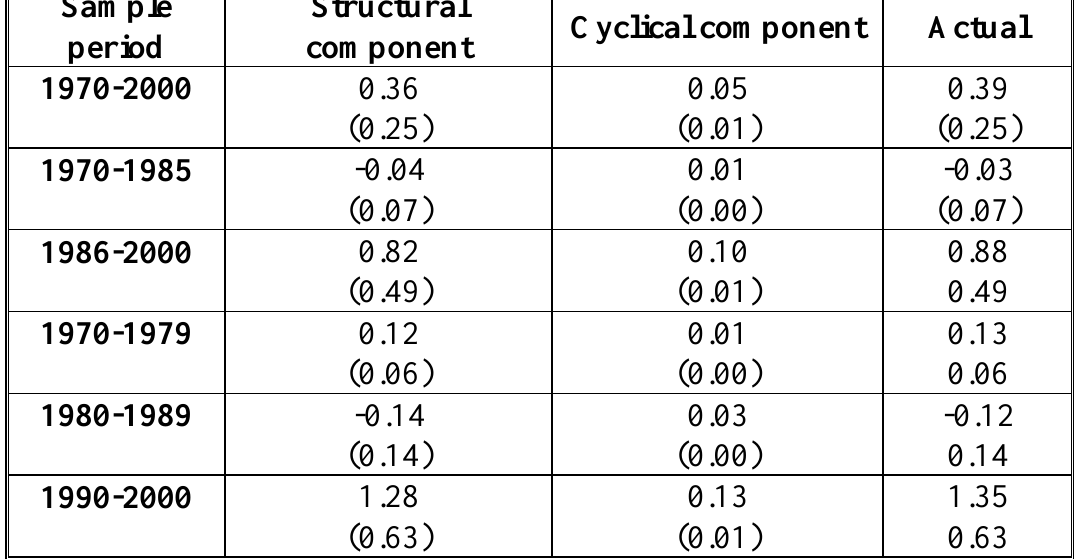
Estimated response of the budget balance to the output gap